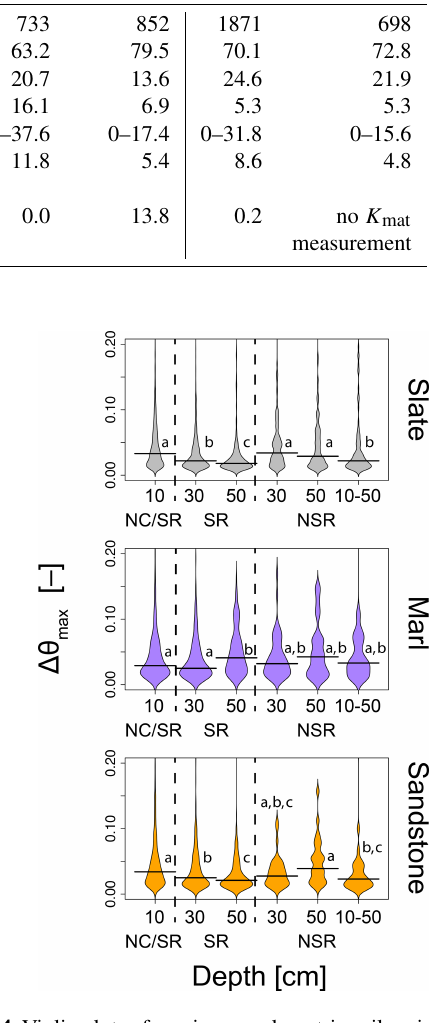
Figure 4. Violin plots of maximum volumetric soil moisture change ( (cid:49)θ max ) per depth for the three geologies and differentiated by infil- tration response. (cid:49)θ max at 10cm could result from a NC response (10cm only) or a SR that ends at a deeper sensor (30 or 50cm). Horizontal lines in the plot indicate the median (cid:49)θ max . Same letters symbolize no significant difference between the response classes of the same geology (Dunn test, two-sided, Benjamini–Hochberg cor- rection, p > 0 .